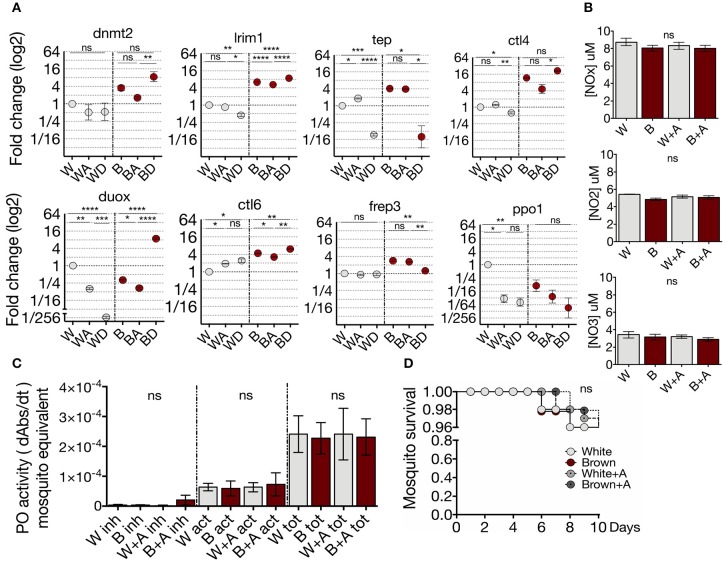
White and Brown phenotypes differ in their regulation of immune genes by methylation. (A) Effect of azacytidine and decitabine in immune gene expression of the phenotypes determined by qPCR and relative to White mosquito's expression. Mean ± SEM of three independent experiments analyzed by ANOVA and Tukey post-hoc test. (B) Effect of the azacytidine treatment on nitric oxide production and (C) phenoloxidase activity in White (W) and Brown (B) phenotypes. Inhibited enzyme (inh), active enzyme (act), and total enzyme (tot). Mean ± SEM of three independent experiments analyzed by ANOVA and Tukey post-hoc test. (D) Brown and White mosquito survival after 72 h of treatment with 50 μM of azacytidine. Mean ± SEM of three independent experiments analyzed by Mantel-Cox test. Asterisks represent the P value as follows: *P < 0.05, **P < 0.01, ***P < 0.001, ****P < 0.0001.